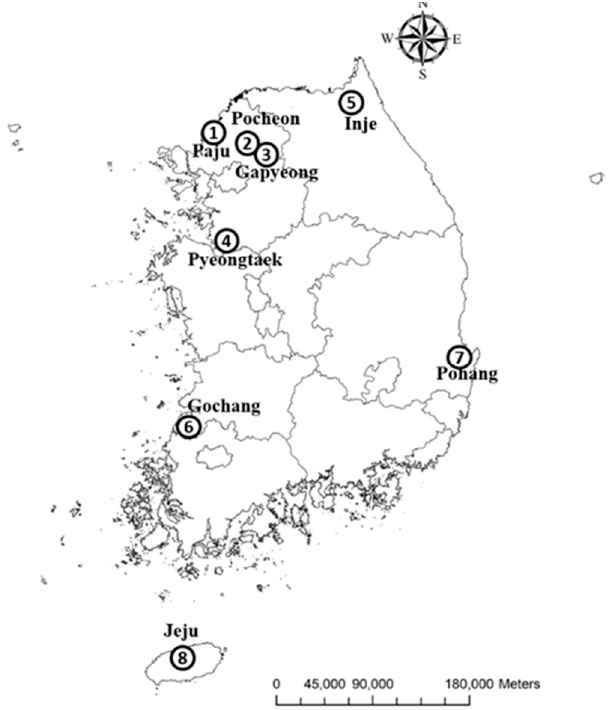
Figure 1. Location of the tick collection points and the severe fever with thrombocytopenia syndrome (SFTS) case. Ticks were collected in: Paju ( 파주시 ; 2015; number 1); Jeju Island ( 제주도 ; 2015–2016; number 8); Pohang ( 포항시 ; 2017; number 7); Gapyeong ( 가평군; 2017; number 3; severe fever with thrombocytopenia syndrome virus (SFTSV)-positive tick pool); Inje ( 인제군; 2017; number 5); Pyeongtaek ( 평택시; 2017; number 4); and Gochang ( 고창군; 2017; number 6). The SFTS patient (Pocheon [ 포천시 ], 2017; number 2) was assigned to the Republic of Korea Army (ROKA) base located at Gapyeong ( 가평군; number 3).